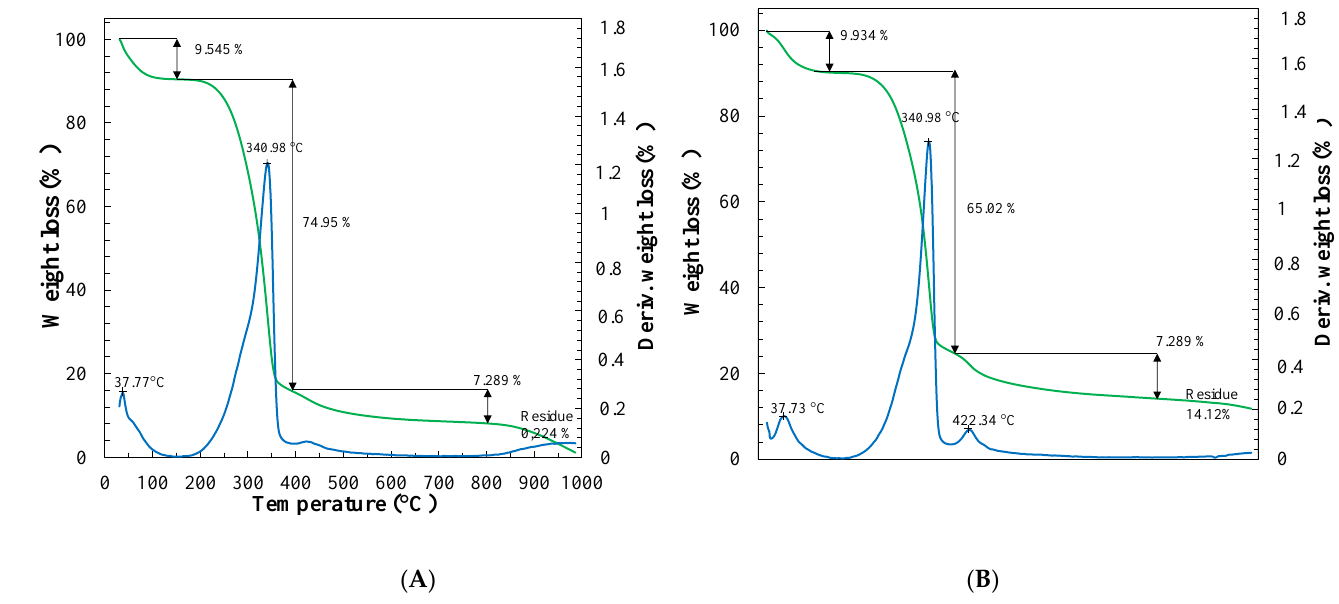
Figure 4. TGA (green) and DTA (blue) of: ( A ) CNP-1F and ( B ) CNP-2A.